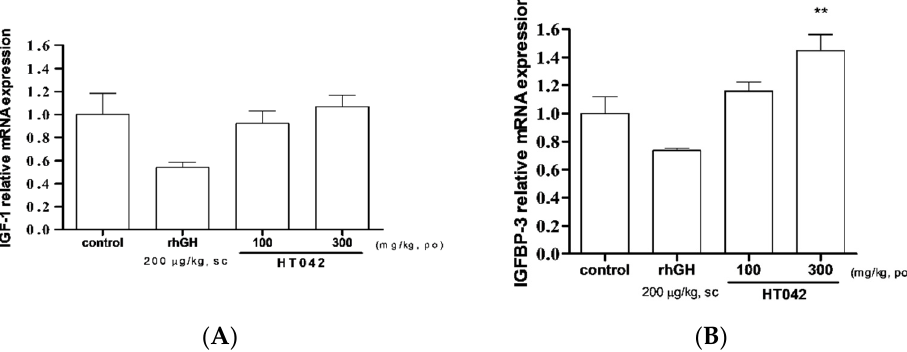
Figure 5. Relative expression of mRNA of ( A ) insulin-like growth factor-1 and ( B ) insulin-like growth factor binding protein-3 in liver measured by quantitative real-time quantitative polymerase chain reaction. Data are expressed as mean ± standard error. ( n = 8 per group), ** p < 0.01.